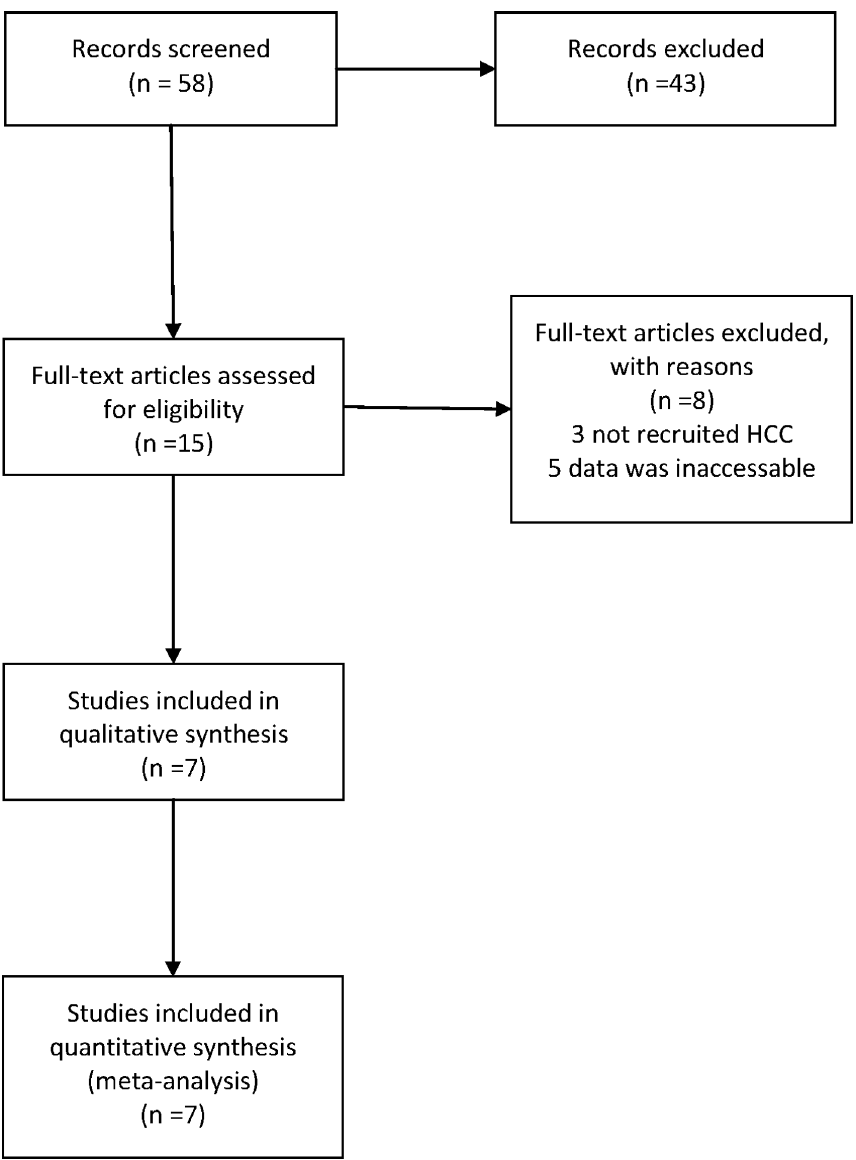
Figure 1. Flow diagram for article screening.